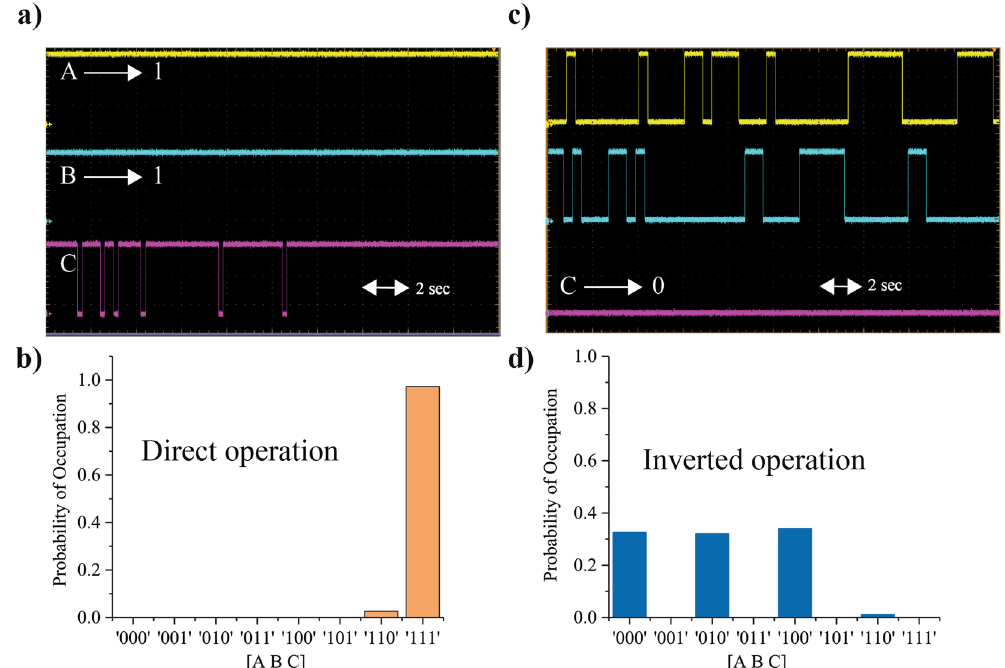
Figure 3. Direct and Inverted operation. ( a ) shows the time evolution of the output voltages of A, B and C on an oscilloscope. When A and B are clamped to 1, C mostly stays at 1 as shown in ( a ) and in the steady-state histogram shown in ( b ). ( c ) Remarkably, the system can operate in the inverted mode: When C is clamped to 0, the inputs A and B fluctuate between 00, 01 and 10, consistent for a C = 0, with approximately equal probability as shown in the steady-state histogram in ( d